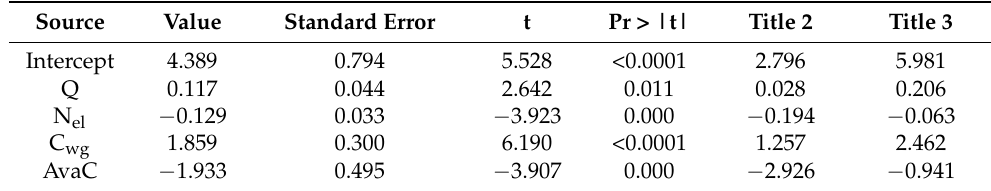
Table 2. Regression model